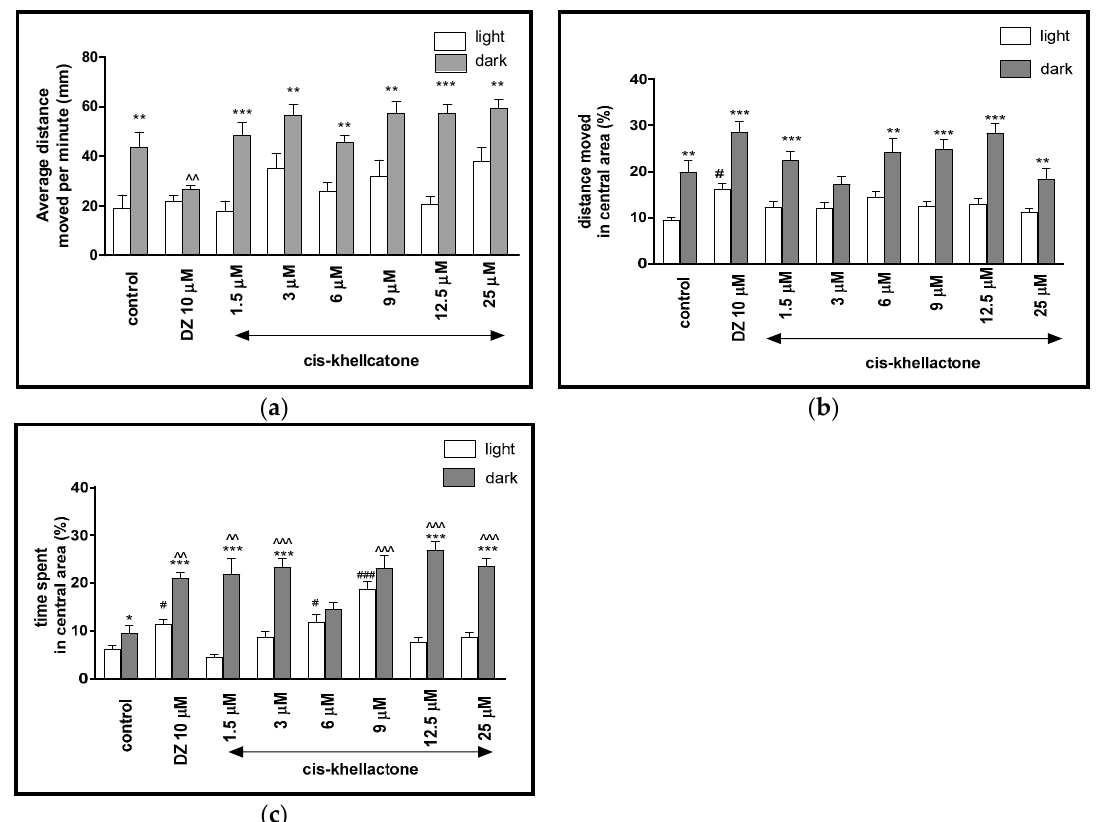
Figure 4. The effects of cis-khellactone (1.5, 3, 6, 9, 12.5 and 25 µM) and diazepam (DZ, 10 µM) on locomotor activity during all three light–dark challenge phase. ( a ) Average distance moved by zebrafish larvae within each 1-min time bin under either light (open bars) or dark (filled bars). ( b ) The percentage of distance moved by zebrafish larvae in the central area during light phase (white bars) or dark phase (filled bars). ( c ) The percentage of time spent by zebrafish larvae in the central area during light phase (white bars) or dark phase (filled bars). Data are presented as mean ± SEM; n = 32. * p < 0.05, ** p < 0.01, *** p < 0.001 in comparison to light conditions within the same concentration group; ^^ p < 0.01, ^^^ p < 0.001 in comparison to control group under dark condition; # p < 0.05, ### p < 0.001 in comparison to control group under light condition (post hoc Bonferroni’s test).